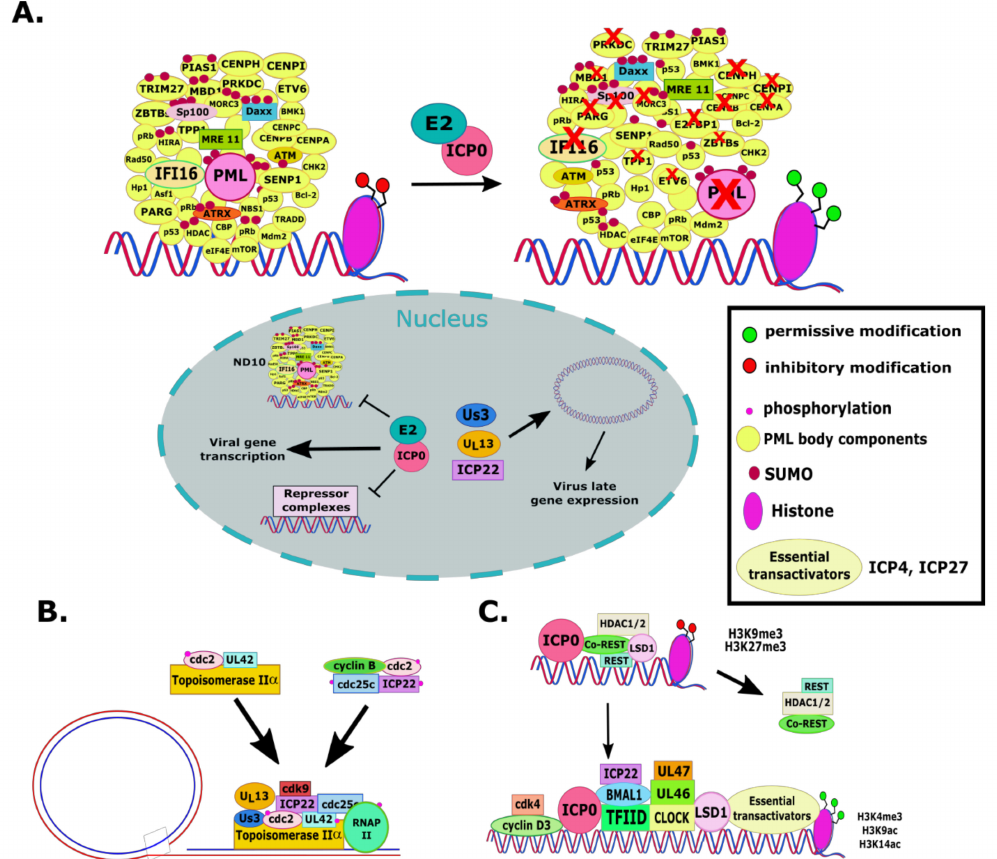
Figure 1. Nuclear functions of non-essential HSV-1 proteins. HSV-1 encodes multiple proteins able to counteract antiviral host responses within the nucleus. ( A ): ICP0 functions as an E3 ligase ubiquitin ligase that degrades ND10 components that encapsulate the viral genome in the nucleus, including PML, Daxx, SP100, centromeric proteins, and others. The degradation of IFI16 involves multiple factors. These events facilitate initiation of viral gene transcription. ( B ): The viral protein ICP0 is also known to disrupt repressor complexes that silence the viral genome, as well as recruit factors to enable viral gene transcription. Altogether, ICP0 facilitates permissive histone modifications, while suppressing silencing modifications, to enable for viral gene expression. ( C ): The viral kinases U S 3 and U L 13, with ICP22, are known to facilitate viral late gene expression, which occurs through the recruitment of host factors, such as Topoisomerase II α and RNA polymerase II, to the sites of DNA replication in the nucleus. Together, these non-essential viral proteins are important for optimal expression of other viral genes and for viral DNA